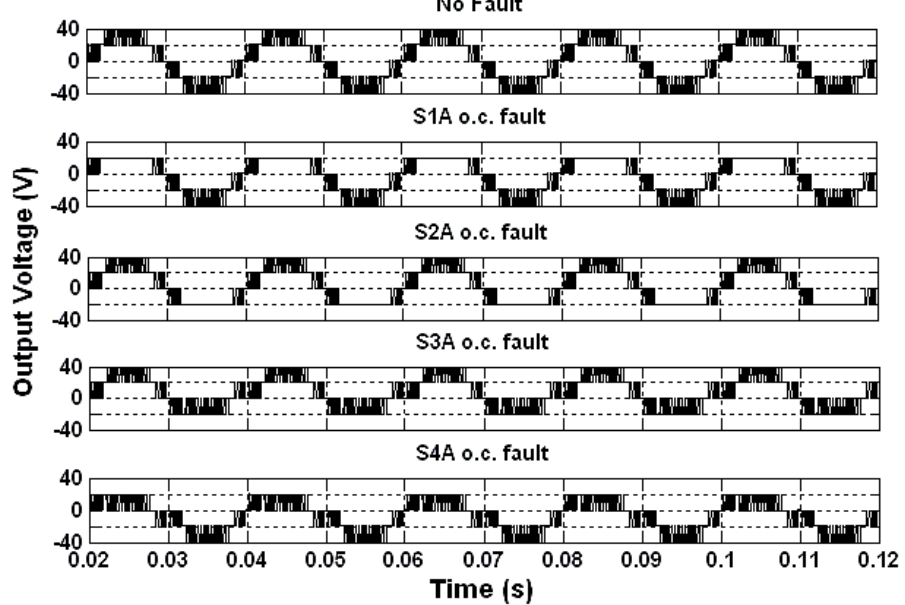
Figure 15. Fault condition output voltage waveforms.